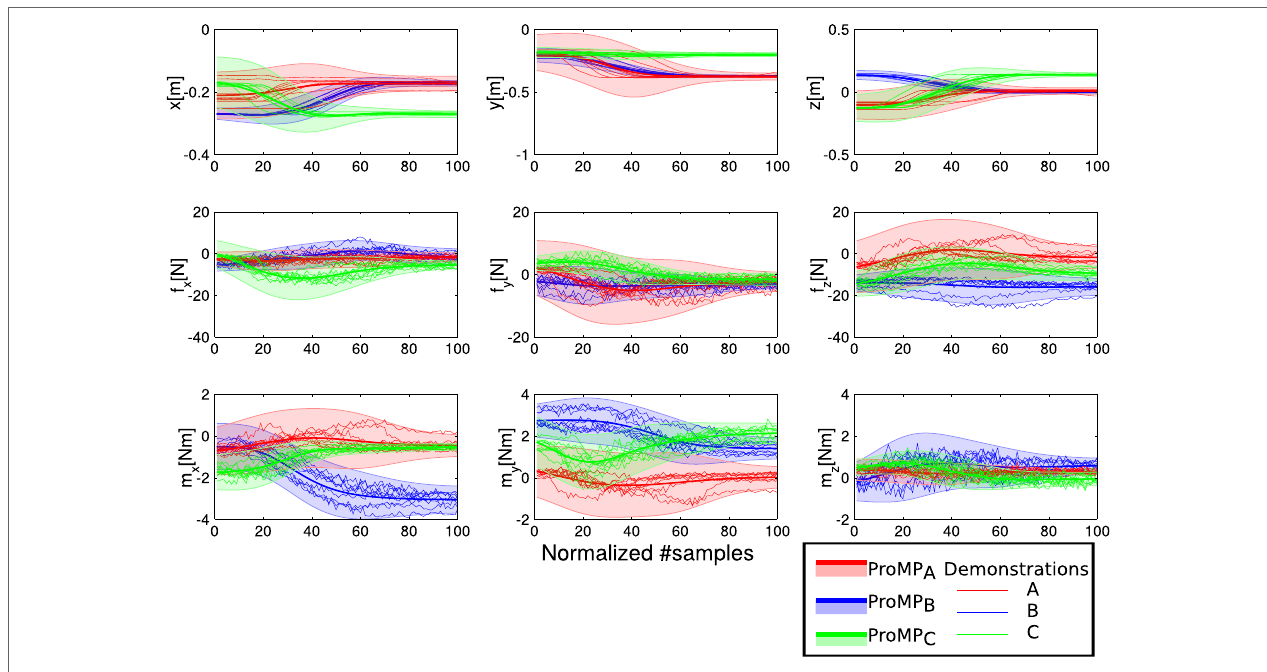
FIGURE 11 | The ProMPs learned by the robot from the demonstrations of Figure 10